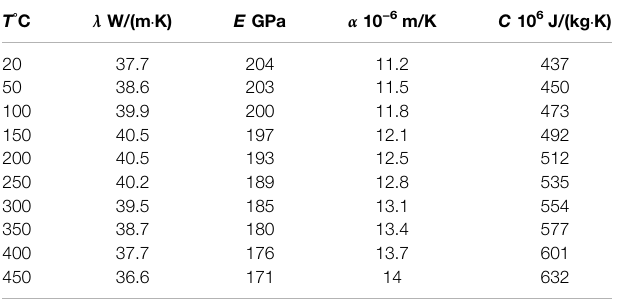
TABLE 4 | Material properties of 16MnD5.